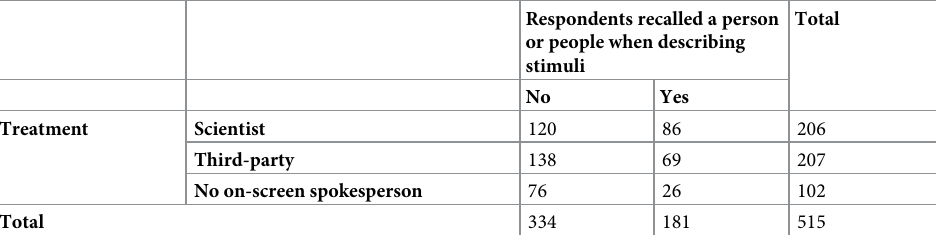
Table 4. Humanizing research results. Observed counts of respondents recalling a person or people when describing the stimuli they viewed by treatment.